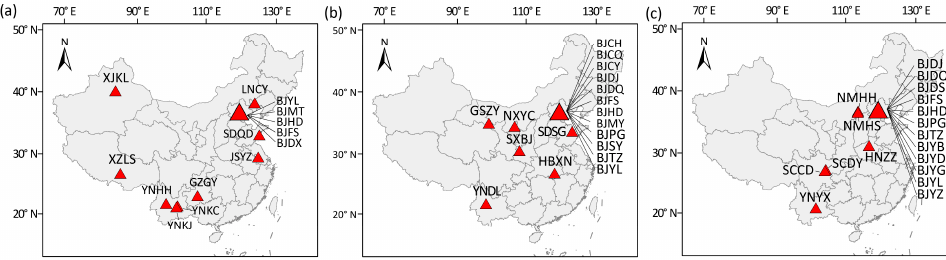
Figure 1. Sample locations (red triangle) of Frankliniella occidentalis populations collected in ( a ) 2009–2013, ( b ) 2014–2018 and ( c ) 2020–2021. The larger red triangle represents multiple populations collected from Beijing.